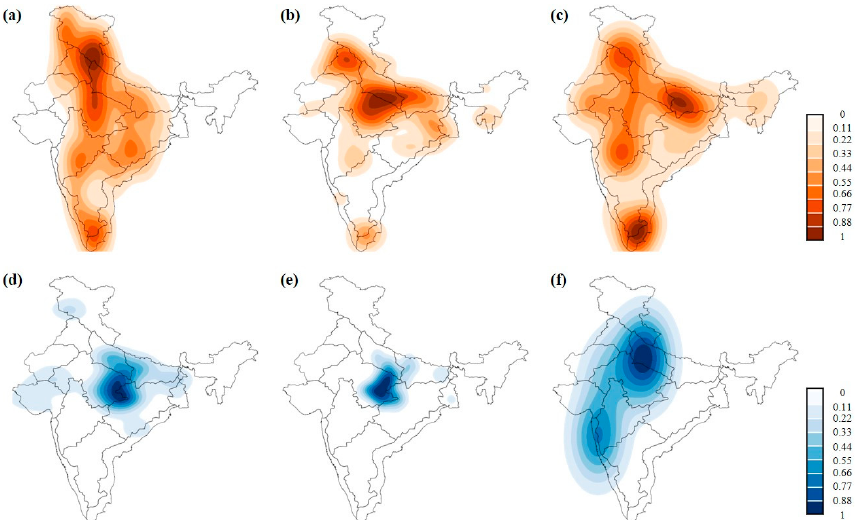
Figure 7. Regions showing statistically significant composite anomalies of rainfall (mm) across India during the month of June when SST anomalies of the Western Indian Ocean ( a , d ), Northern Indian Ocean ( b , e ) and Central Indian Ocean ( c , f ) demonstrated positive (upper) and negative (lower) variations. The colour bar shows the scaled density estimate of negative (orange) and positive (blue) rainfall anomalies. The warmer SST in the oceanic regions leads to negative rainfall anomalies, while the colder SST leads to positive rainfall anomalies in the shaded areas.